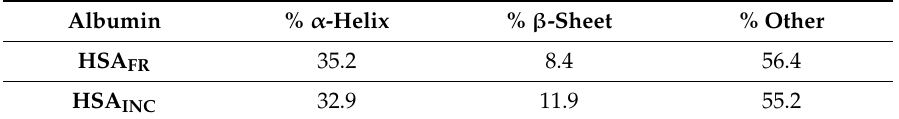
Table 5. The percentage (%) content of the secondary structure elements of HSA FR and HSA INC